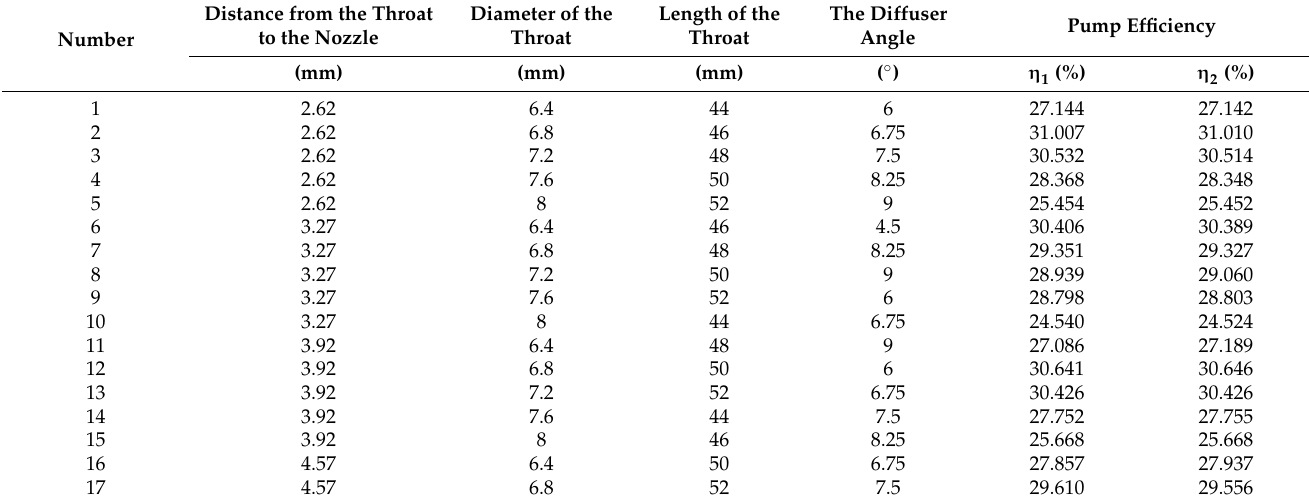
Table 10. Orthogonal table and the results of these